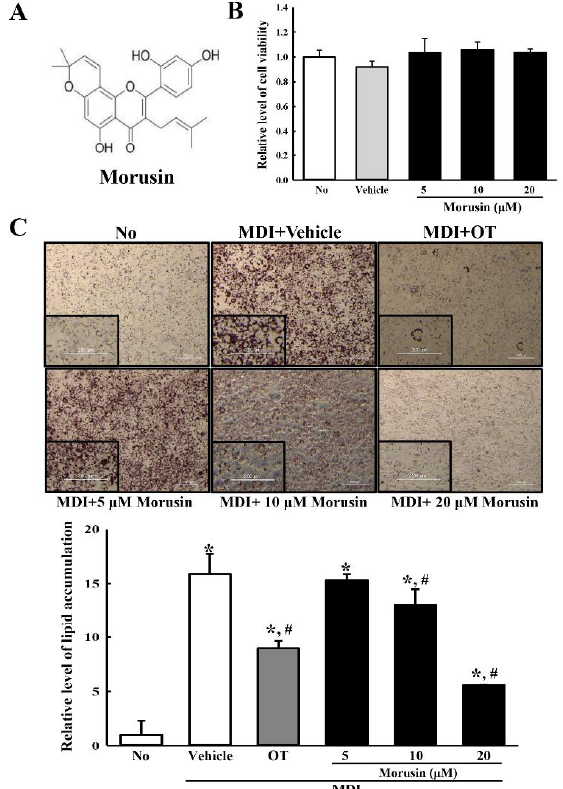
Figure 1. Chemical structure and cytotoxicity of morusin. ( A ) Chemical structure of morusin; ( B ) Viability of 3T3-L1 adipocytes to morusin. After incubation with morusin for 24 h, the cell